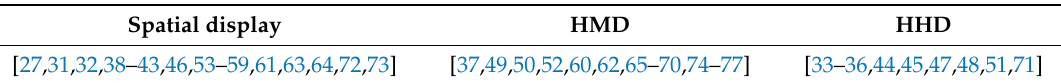
Table 9. Platforms of selected studies.